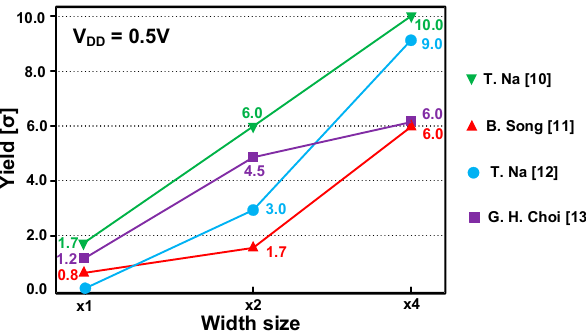
Figure 9. Restore yield of state-of-the-art NVFFs relative to the width size of all devices when MTJ stress time = 1.5 ns, V DD = 0.5 V, and SS corner.